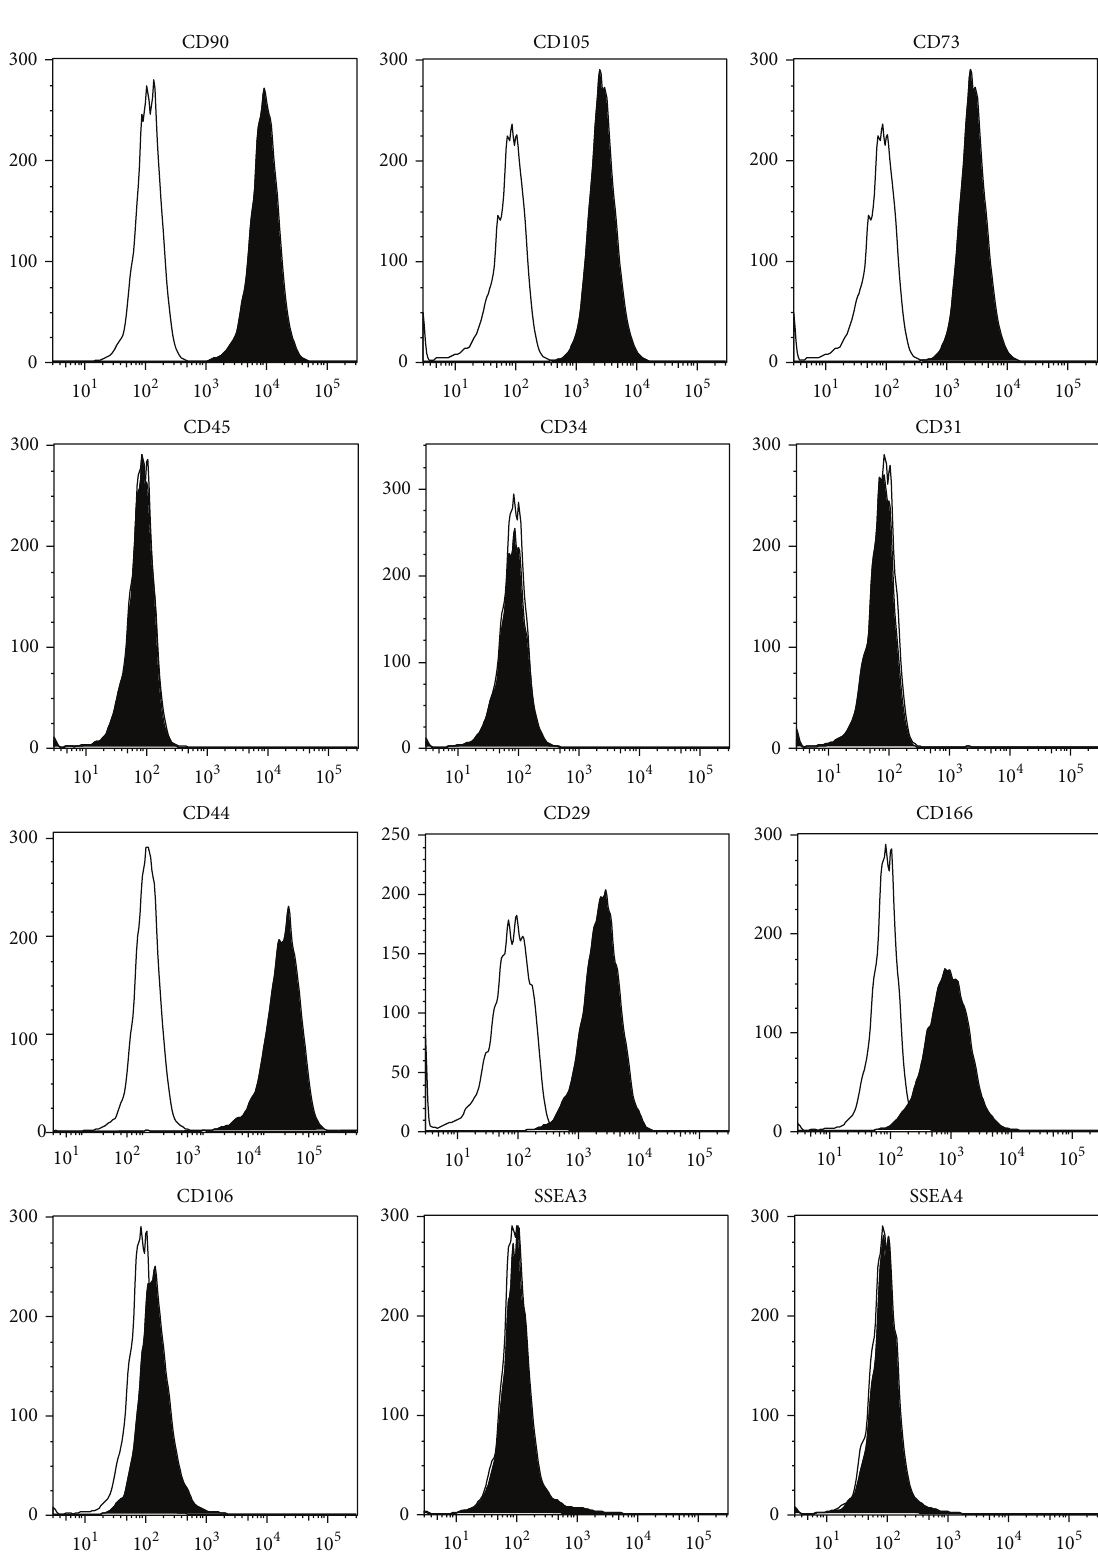
Figure 1: Expression of surface markers in P 3 hADSCs. The black filled histograms indicate the positive stained cells while the white filled histograms indicate the isotype-matched antibody